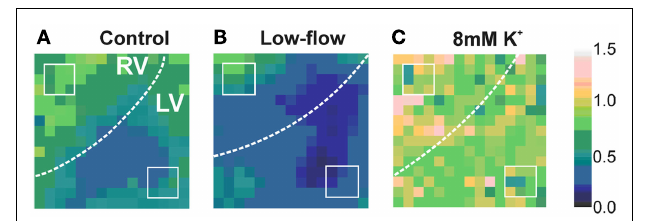
FIGURE 4 | Color-coded maps of fractional change in optical signal amplitude duringVF at 480s. (White dotted lines = LV/RV boundary, white squares = standardized areas to determine ventricular optical amplitude). (A) Fractional change under control conditions (perfused) (B) during low flow ischaemia (C) during perfusion with 8mM